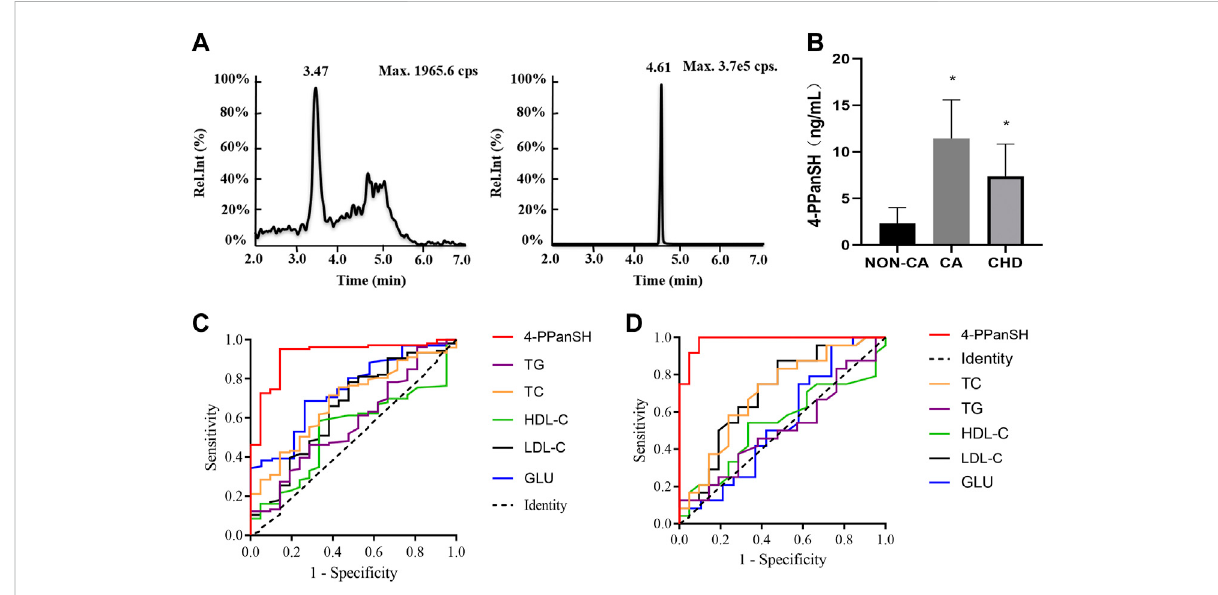
FIGURE 2 4-PPanSH provided better suggestions for the potential CHD high-risk and CHD groups. (A) Representative chromatograms of 4-PPanSH and Car-d10 in human plasma. (B) 4-PPanSH was signi fi cantly higher in the CA group and decreased after the diagnosis of CHD was con fi rmed. (C) 4- PPanSH was more effective than traditional indices of CHD patients. (D) 4-PPanSH was more effective than the traditional indexes of the potential CHD high-risk groups. *Indicates p < 0.05 compared to the NON-CA group.